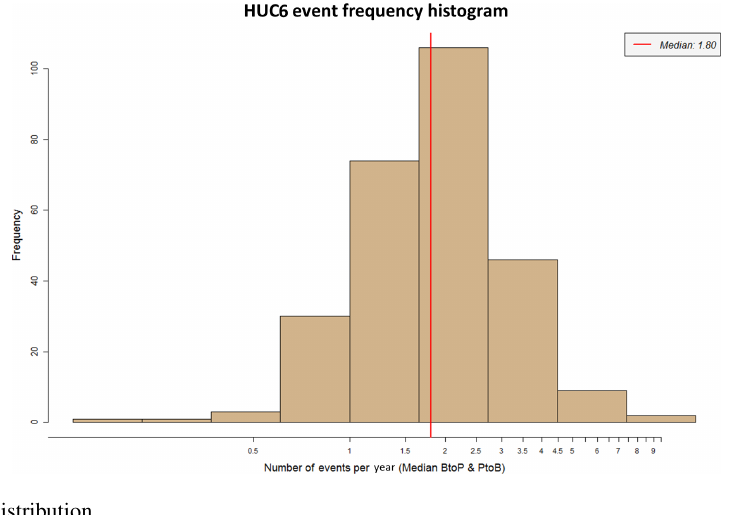
Figure 7. HUC6 frequency distribution.